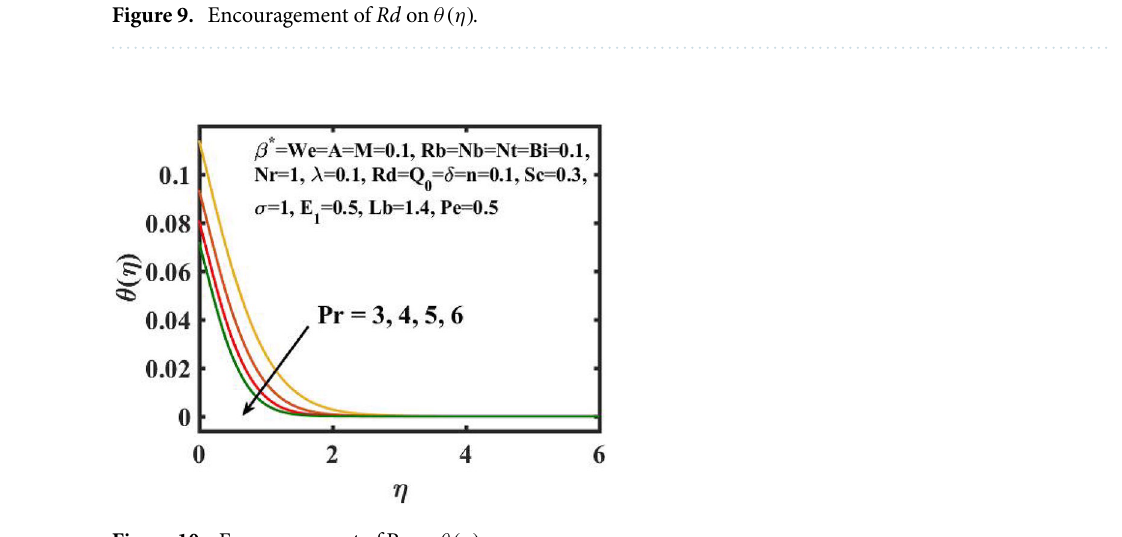
Figure 10. Encouragement of Pr on θ(η) .